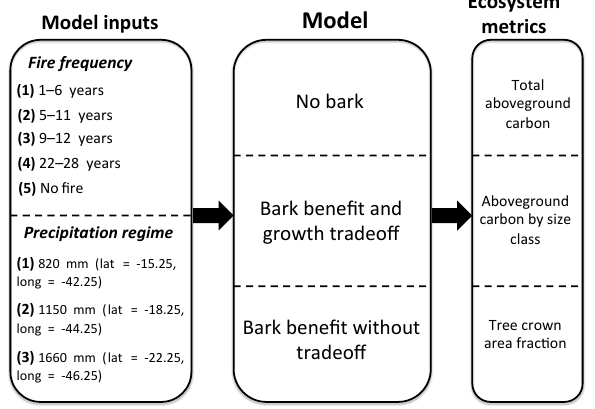
Figure 1. Schematic of model experiments along a rainfall gradi- ent. Varied model inputs include fire frequency and precipitation regime (associated with a particular study site locations in the Cer- rado region of South America). Different model versions were used to understand the effect of including bark as a fire survival strategy on model outputs of various ecosystem metrics including above- ground woody carbon, tree size class distribution, and tree crown area